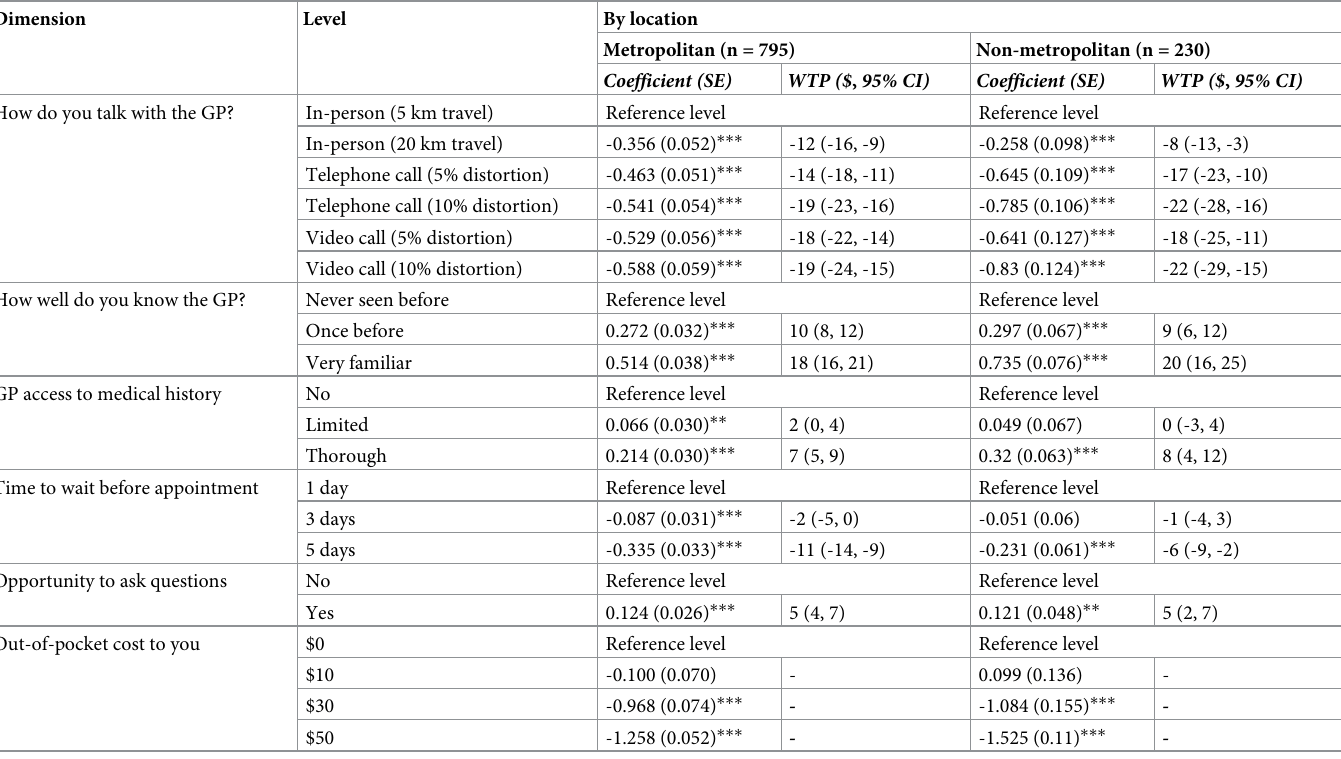
Table 4. Results from conditional logit models, by location.